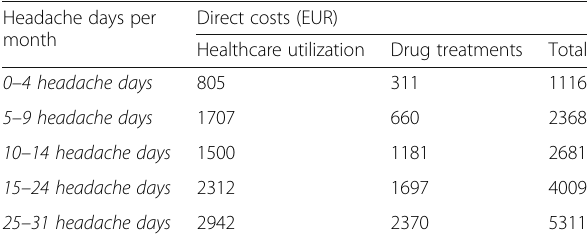
Table 3 Annual average direct costs by number of